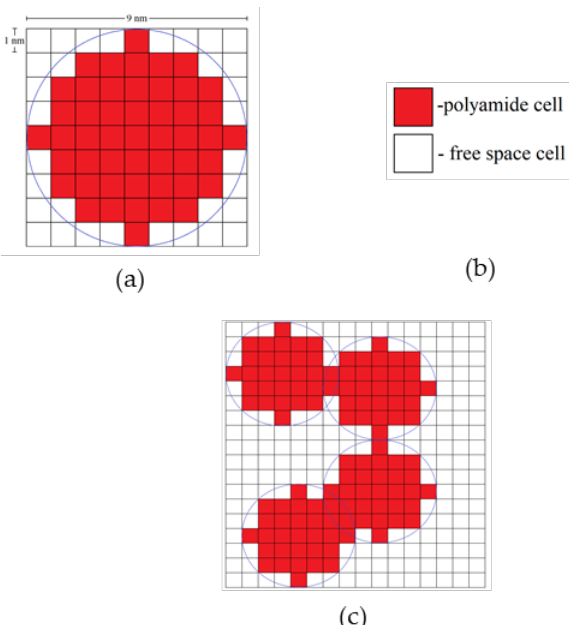
Figure 15. Two-dimensional globule with a diameter of 9 nm ( a ); types of cells in developed the DLCA model ( b ) and aggregated 2D globules with a diameter of 7 nm ( c ).